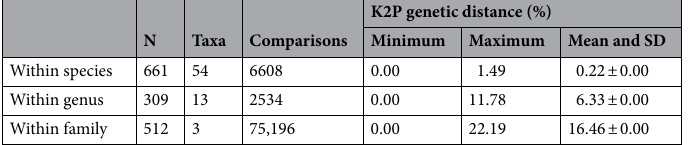
Table 2. Summary of K2P genetic distances (%) calculated for different taxonomic levels.